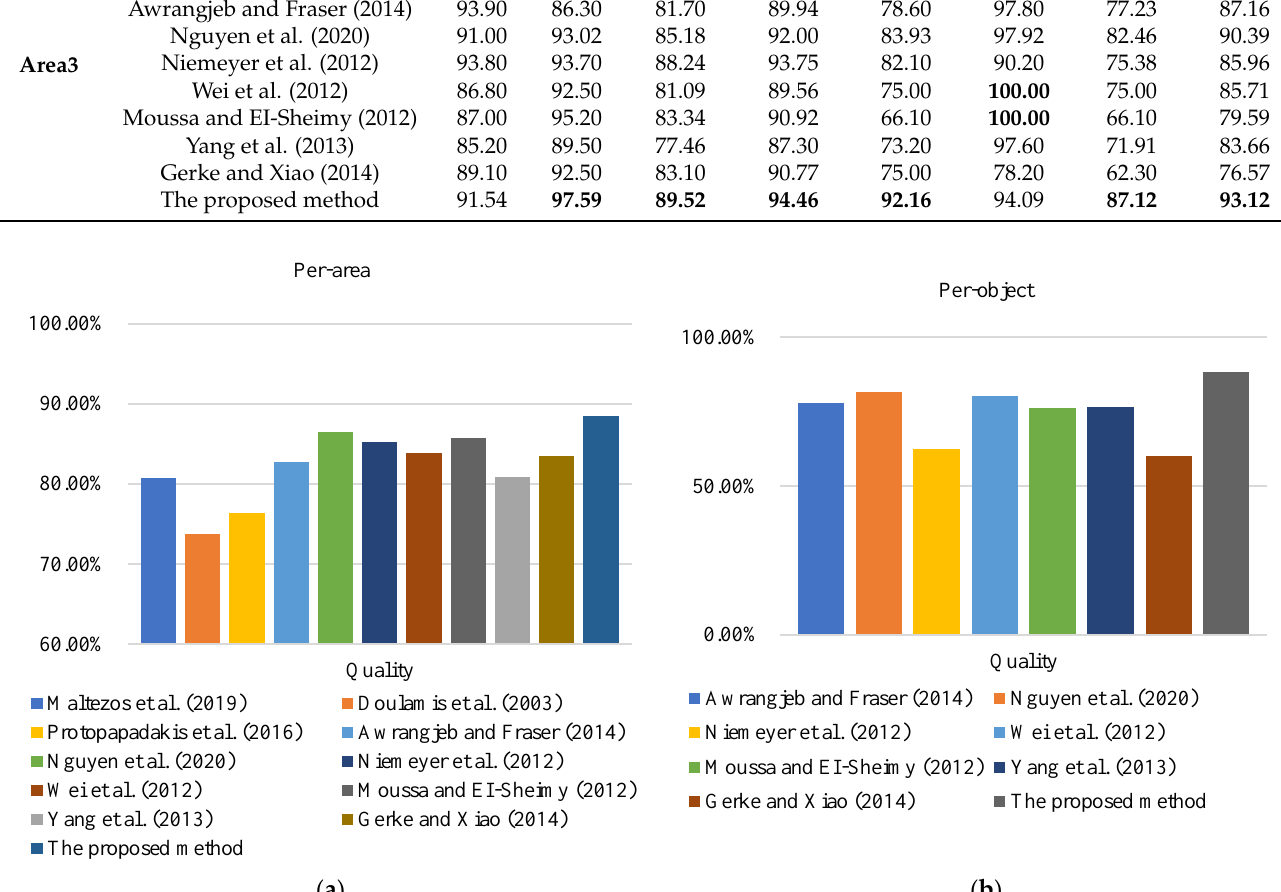
Figure 6. Average quality comparison between the proposed method and ten other methods. ( a ) Per-area level; ( b ) per-object level. The average qualities of the ten methods are obtained from the corresponding references. The methods proposed by Maltezos et al. (2019), Doulamis et al. (2003) and Protopapadakis et al. (2016) do not provide the quality at per-object level.